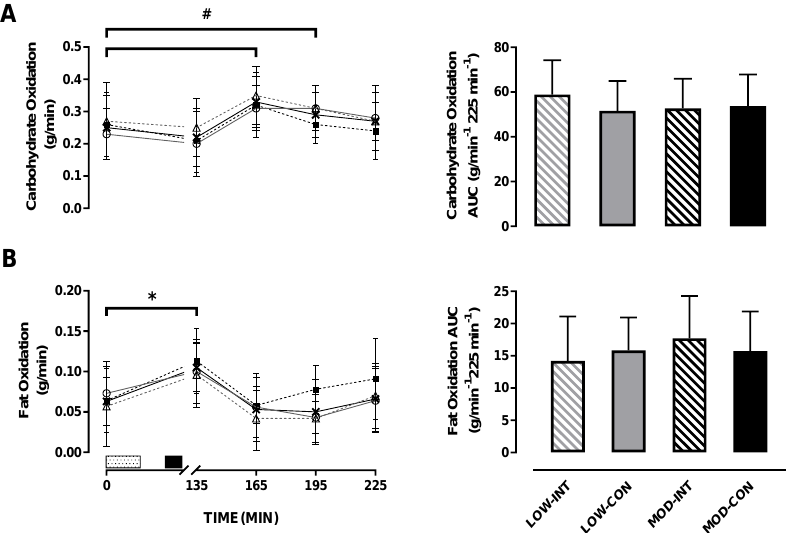
Figure 4. ( A ) Carbohydrate oxidation, and ( B ) fat oxidation during the LOW-INT ( ▲ ), LOW-CON ( ○ ), MOD-INT ( ■ ) and MOD-CON (x). Solid lines represent continuous trials and hashed lines represent intermittent trials. Data points are means with vertical error bars representing SDs ( n = 12). Unfilled rectangle with black spots indicates 60-min exercise period; filled rectangle indicates ingestion of a semi-solid meal; 135, 165, 195 and 225-min represent post-meal measurements. Bar charts represent mean AUC responses (0–225 min) to a standardised meal after exercise, with vertical error bars representing SDs. # Indicates LOW- CON trials significantly increased from baseline to 60 and 90-min post-meal. * Indicates MOD-INT and CON trials significantly increased from baseline to 30-min post-meal determined by Bonferroni adjusted paired t-test ( p < 0.05).